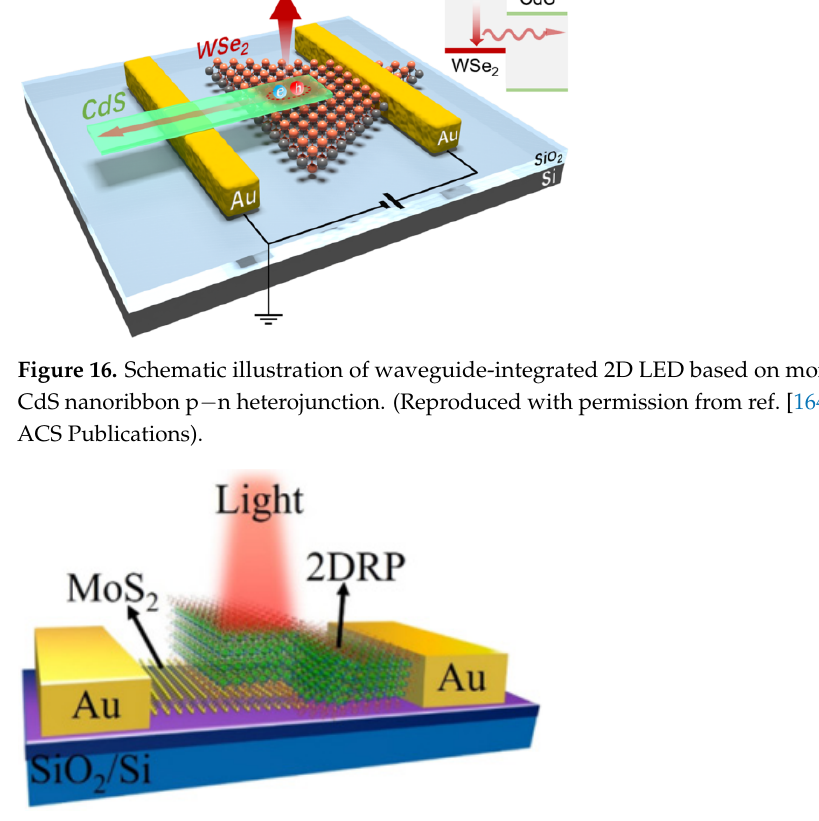
Figure 17. Schematic diagram of the photodetector fabricated from the MoS 2 /2D Ruddlesden − Popper perovskite heterostructure. (Reproduced with permission from ref. [170]. Copyright 2022 ACS Publications).